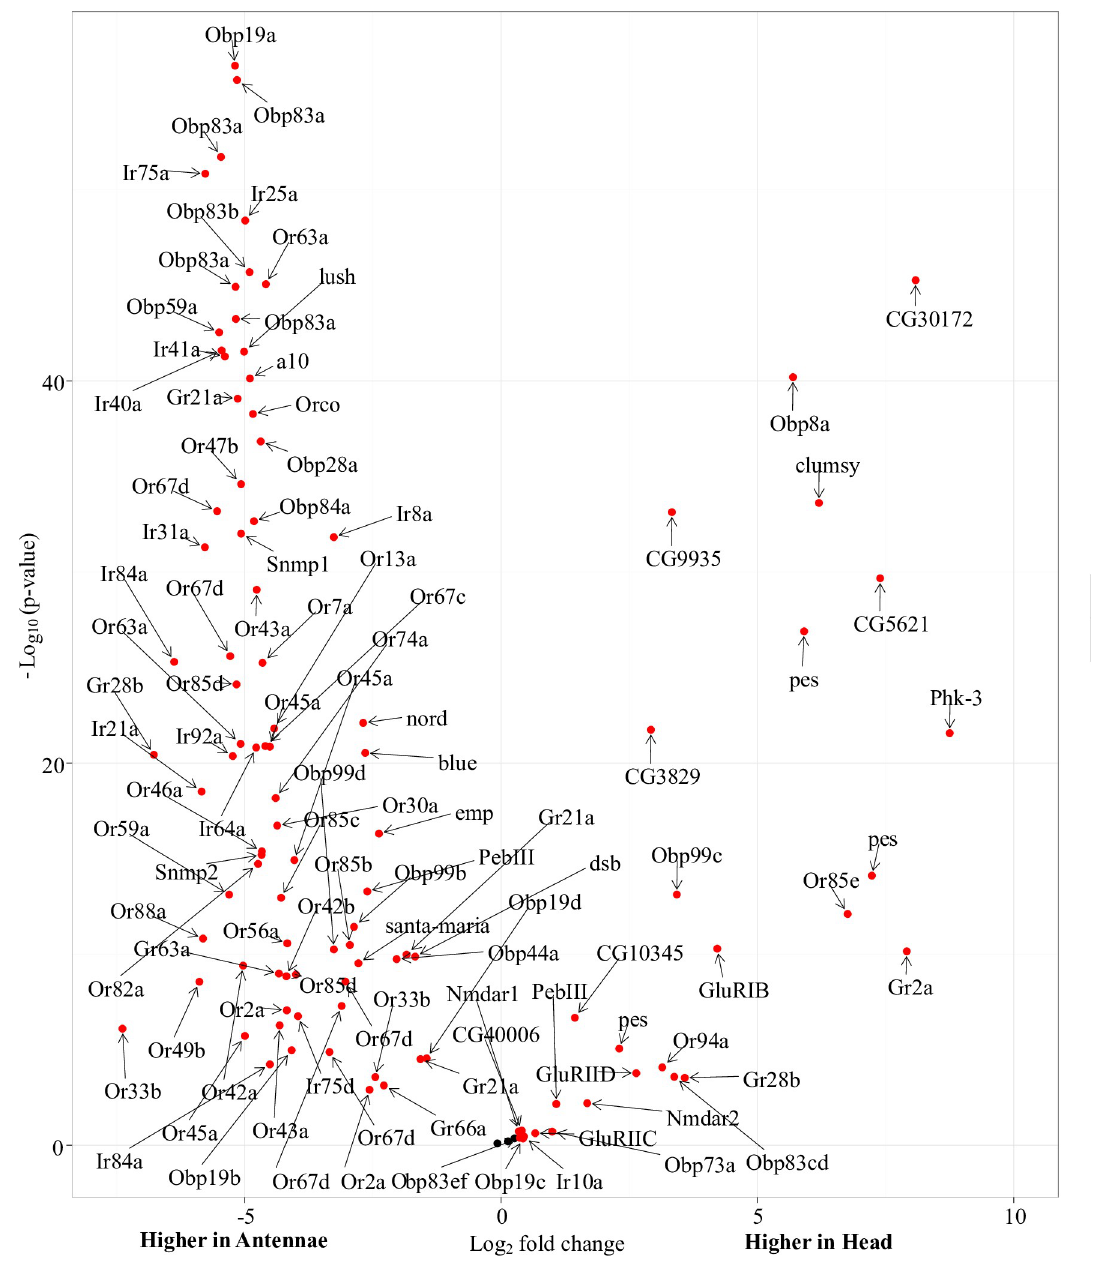
Fig 5. Volcano plot showing abundantly and significantly expressed chemosensory gene orthologs between the male G . m . morsitans head and antennae transcriptomes. Dots indicate points-of-interest that display fold-changes (x axis) and statistical significance (-log10 of p value, y axis) in transcripts between the head and antennae transcriptomes. Red dots indicate transcripts with fold-changes of two or more (log 2 � 1) and False Detection Rate (FDR) corrected p values of less than 0.05 and are indicate transcripts with significant changes between the transcriptomes. Black dots represent transcripts with non-significant changes between the